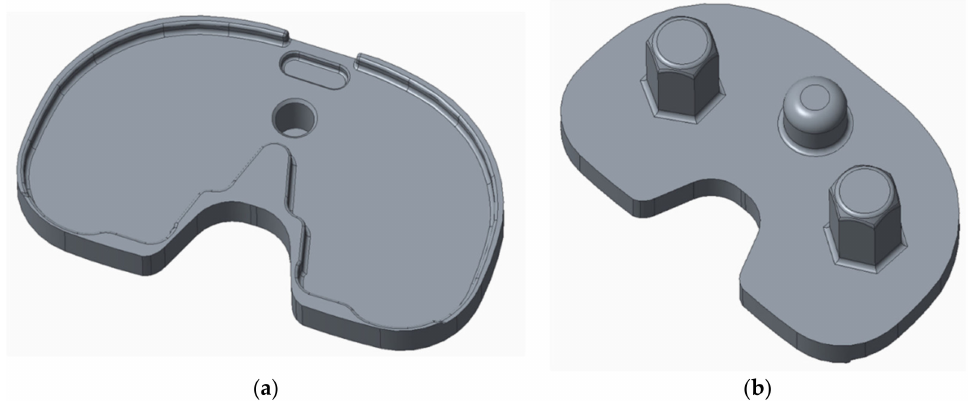
Figure 9. Numerical model of the tibial tray viewed from above ( a ) and from below ( b ).